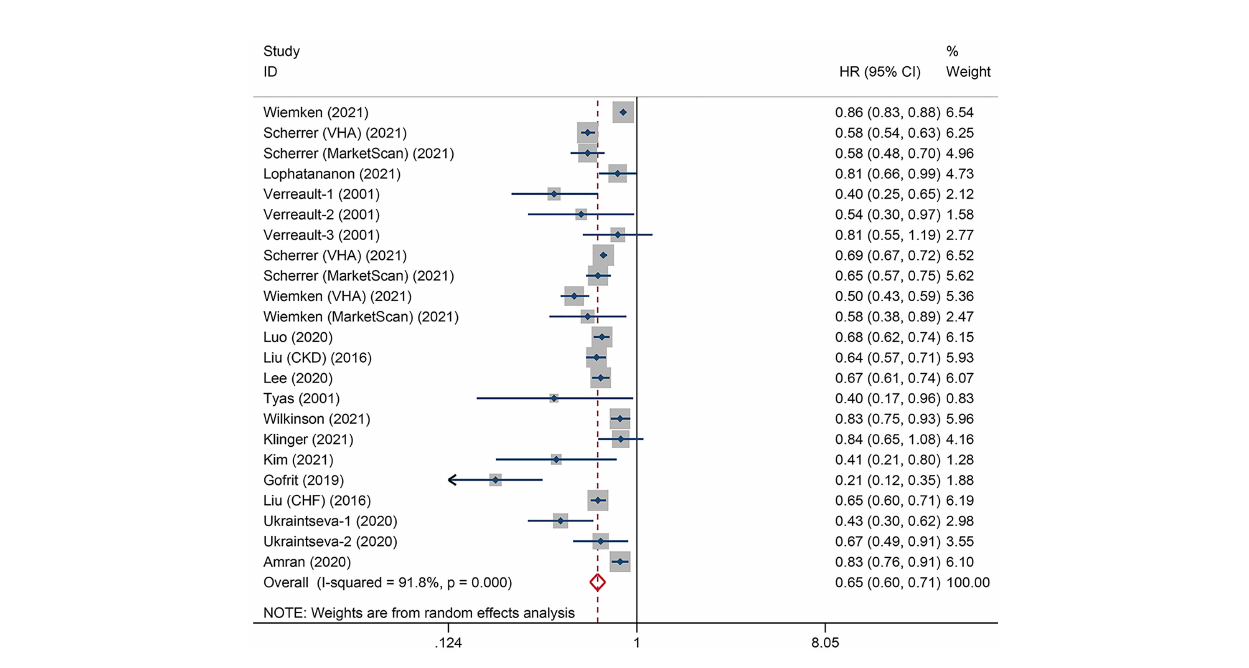
FIGURE 2 | Overall association between adult vaccinations and subsequent dementia risk.